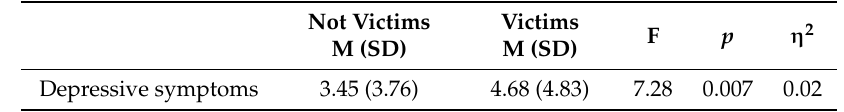
Table 5. Depressive symptoms: comparison between not victims and victims (one-way ANOVA).